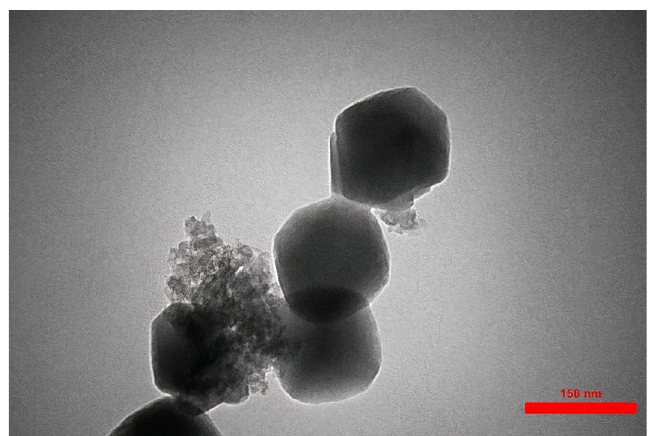
Figure 8. TEM analysis of Fe 3 O 4 @UiO@DAS.